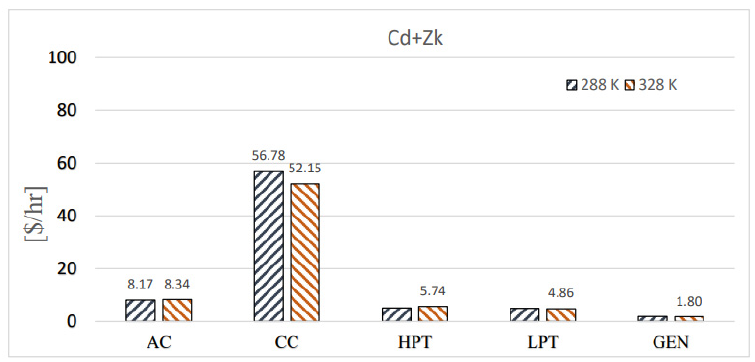
. . T C d + Z k ) for GT (axial compressor) at ISO (288 K)